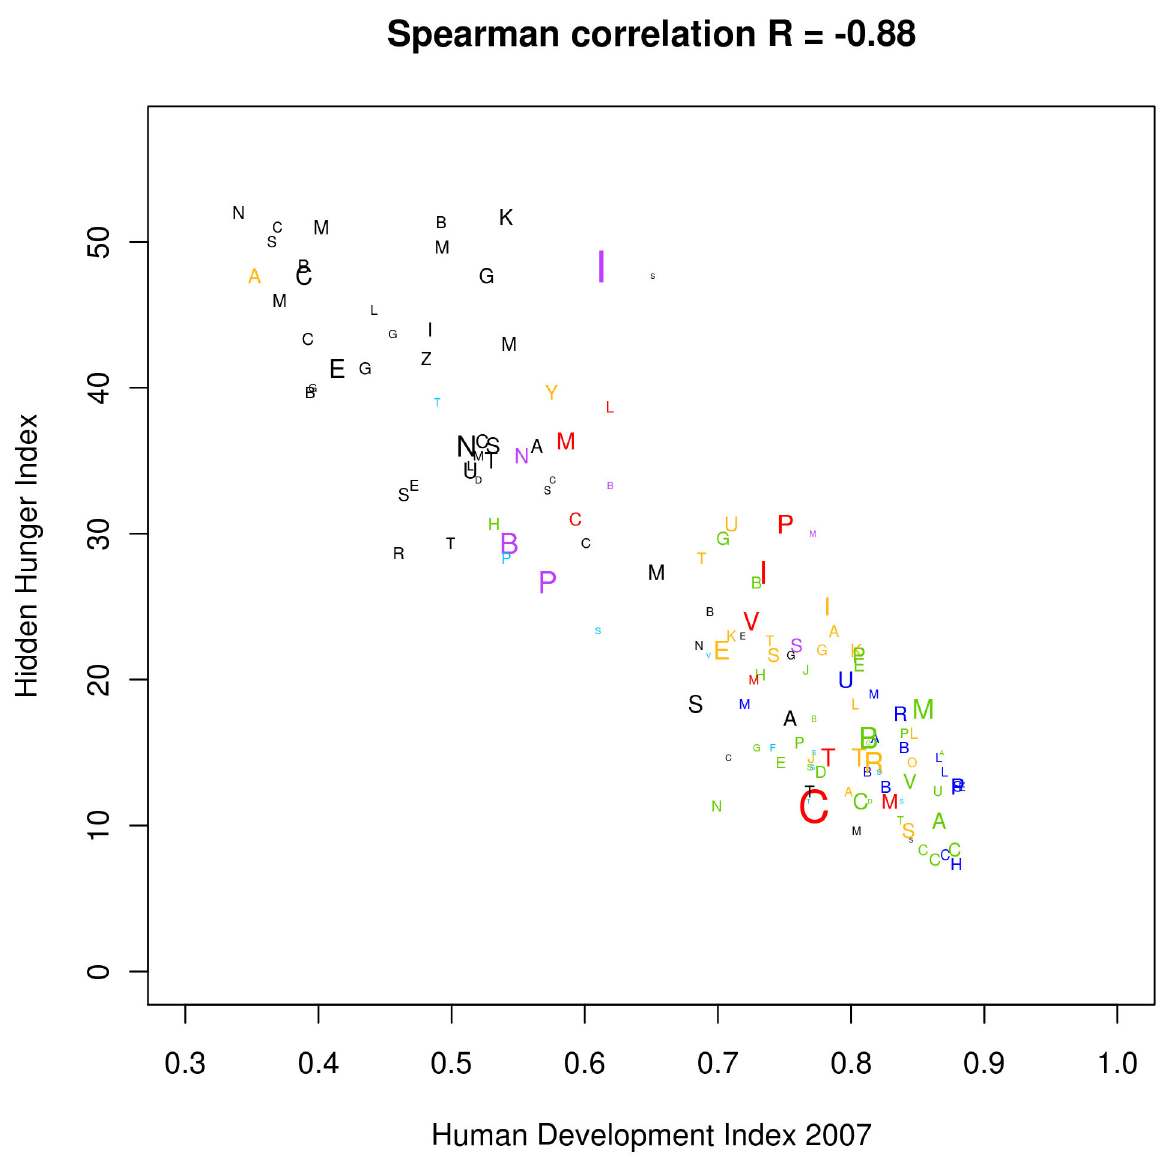
Figure 3. The association between hidden hunger index based on the prevalence estimates (HHI-PD) and 2007 Human Development Index (HDI). The alphabet characters symbolize the first initial of each country; the font sizes are proportional to the population size. Font color represents different regions, such that black represents Africa; red, East Asia; yellow, West Central Asia; green, Central and South America; turquoise, the Pacific Islands, and the Caribbean; purple, South Asia; and blue, Europe, North America, Australia, and New